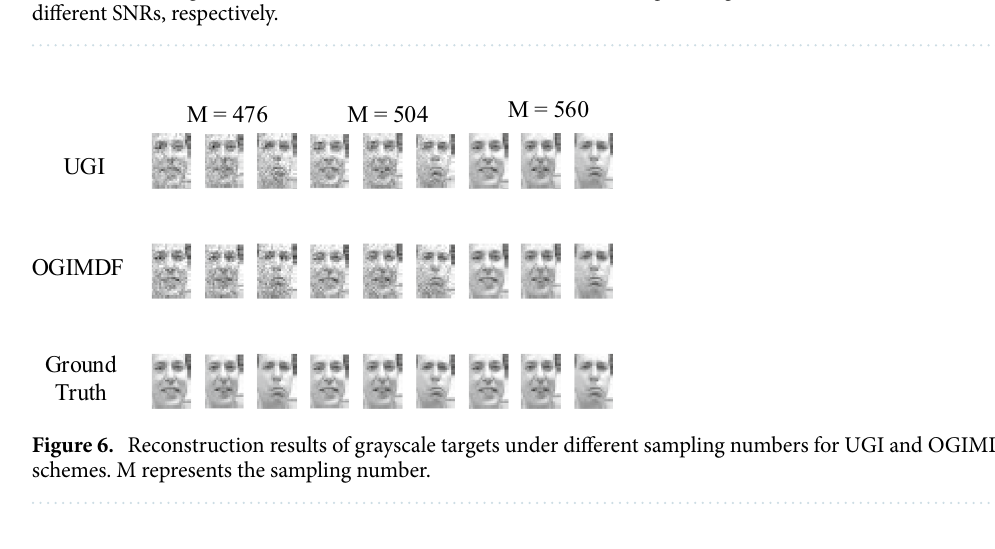
Figure 5. Simulation results of three schemes under different SNRs with SR = 0.50. ( a ) The images in the first row are reconstructed using Xu method, the second row shows the images reconstructed using UGI, the third row shows the restored objects using OGIMDF, and the images in the last row are the ground truth. ( b ) and ( c ) show the change curves of PSNR and MSSIM of reconstructed images using Xu, UGI and OGIMDF under different SNRs, respectively.